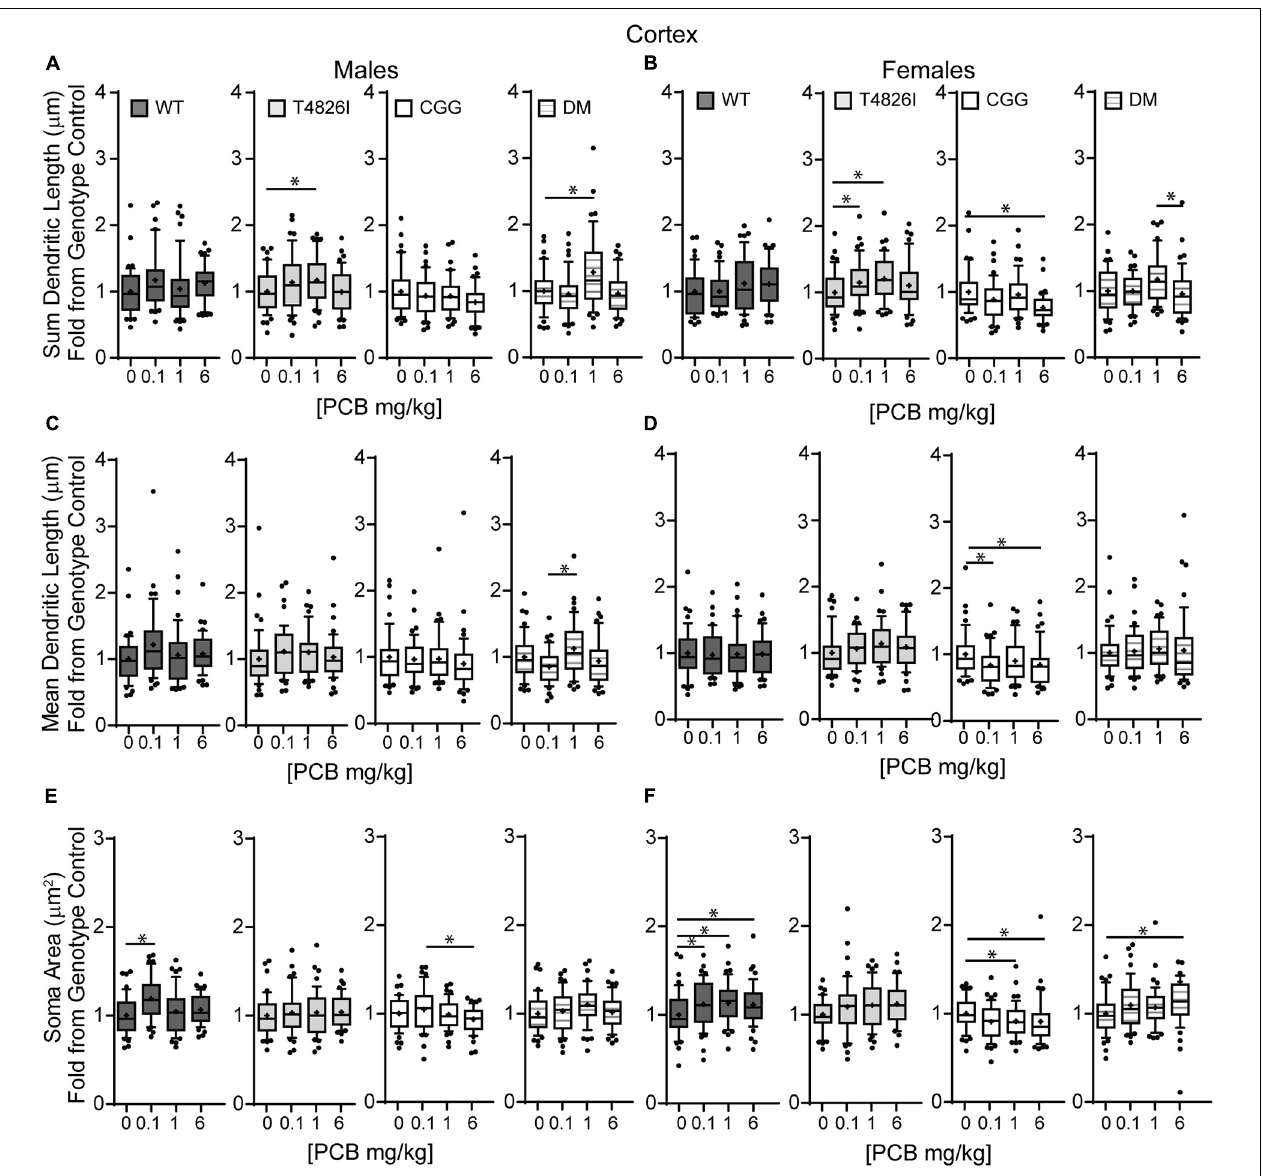
FIGURE 6 | Polychlorinated biphenyls effects on dendritic length and soma area are more prevalent in female vs. male pyramidal somatosensory cortical neurons. Morphometric analyses of the basilar dendritic arbors of Golgi-stained pyramidal CA1 hippocampal neurons from P27–31 male and female WT, T4826I, CGG, or DM mice exposed to the MARBLES PCB mixture in the maternal diet throughout gestation and lactation. (A,B) Sum length of dendrites per neuron ( µ m). (C,D) Mean dendritic length per neuron ( µ m). (E,F) Cell body area ( µ m 2 ). Data ( N = 44–48 neurons from at least six independent mice per sex per genotype per dose) are presented as box plots, where the box indicates the lower (25th) to upper (75th) quartiles, the “+” indicates the mean, whiskers indicate the 10–90th percentile, and dots represent values outside the upper or lower fences. Bar and asterisk indicate a significant difference between groups as determined by Kruskal–Wallis test followed by Dunn’s multiple comparisons test, or (A-T4826I, E-WT, DM) one-way ANOVA followed by Dunnett’s multiple comparisons test or (E-CGG) one-way ANOVA with Welch’s correction followed by Dunnett’s T3 multiple comparison test with p ≤ 0.05 considered statistically significant. Average values of vehicle controls for WT, T4826I, CGG and DM, respectively, are (A) 582.2, 583.0, 699.4, 617.5 µ m; (B) 603.1, 591.4, 740.5, 612.1 µ m; (C) 94.7, 96.9, 113.8, 110.5 µ m; (D) 108.6, 99.8, 123.7, 100.2 µ m; (E) 229.2, 228.0, 256.1, 235.1 µ m 2 ; and (F) 233.2, 224.6, 267.3, 222.9 µ m 2 .